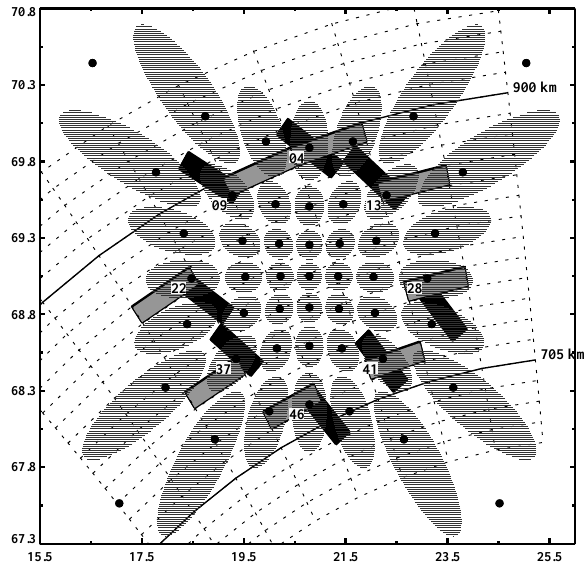
Fig. 1. The experimental setup in Northern Scandinavia showing the central positions of IRIS beams at 90km by black circles, pro- jections of the 3-dB IRIS beams by contours filled with horizontal lines, STARE Finland radar cells near the IRIS FoV by dotted con- tours, and STARE Finland (grey) and Norway (black) radar cells closest to the selected IRIS beams with digits nearby indicating the IRIS beam